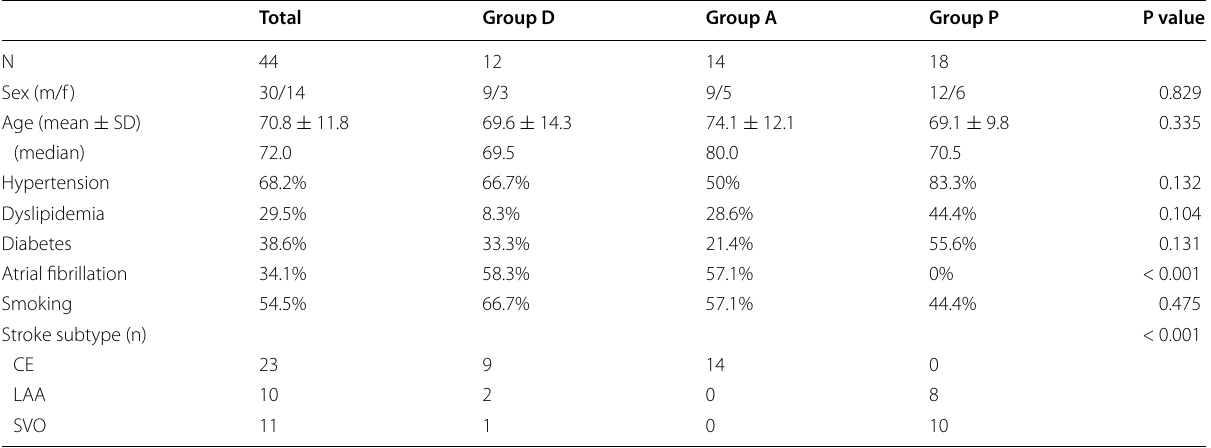
Normal range of each factor is indicated in parentheses. Data are presented as average